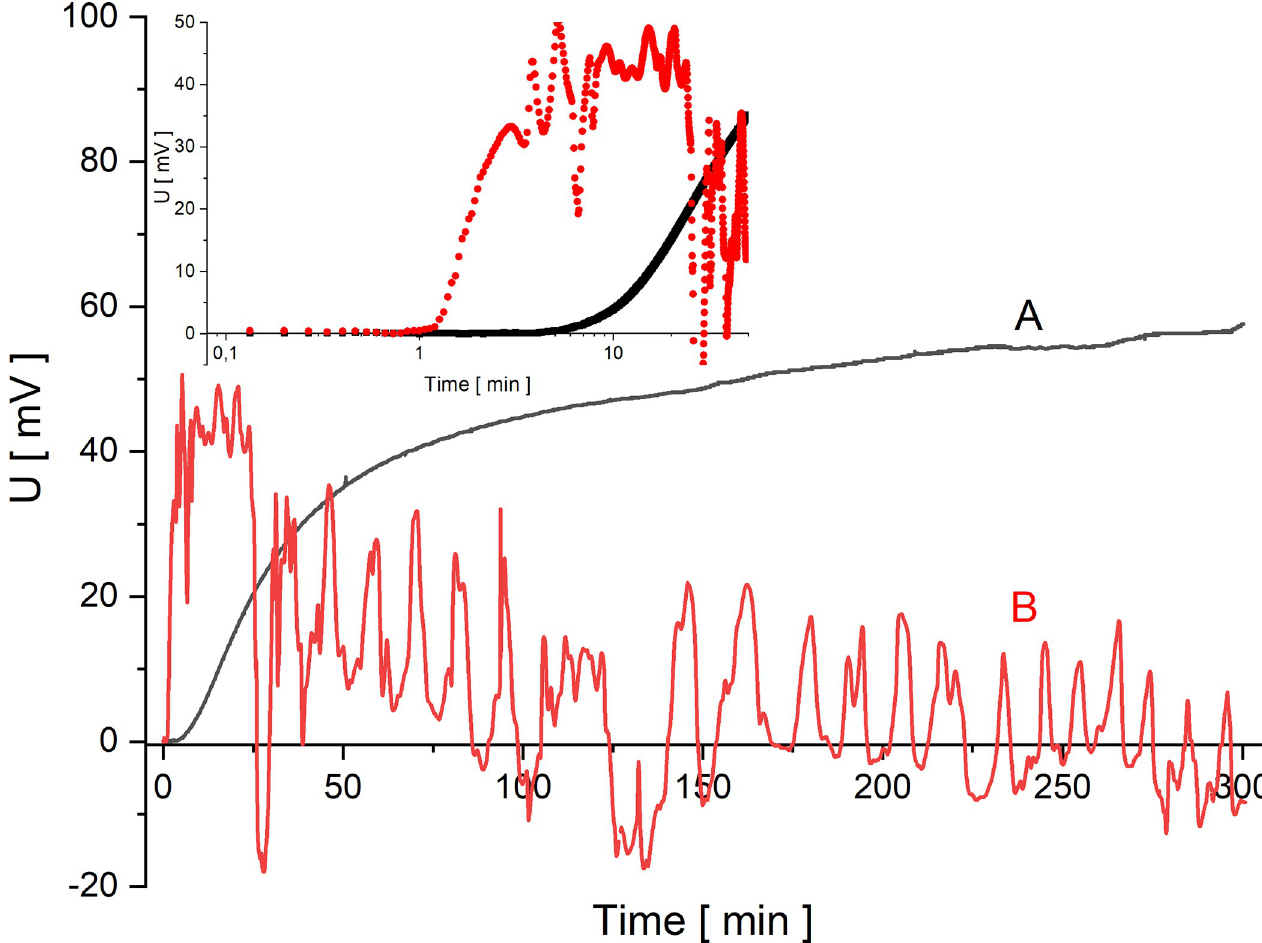
Fig 4. Voltage between electrodesin the chamberwith lower concentration as a functionof time for configurations A (black) and B (red) and for C h / C l = 1000.